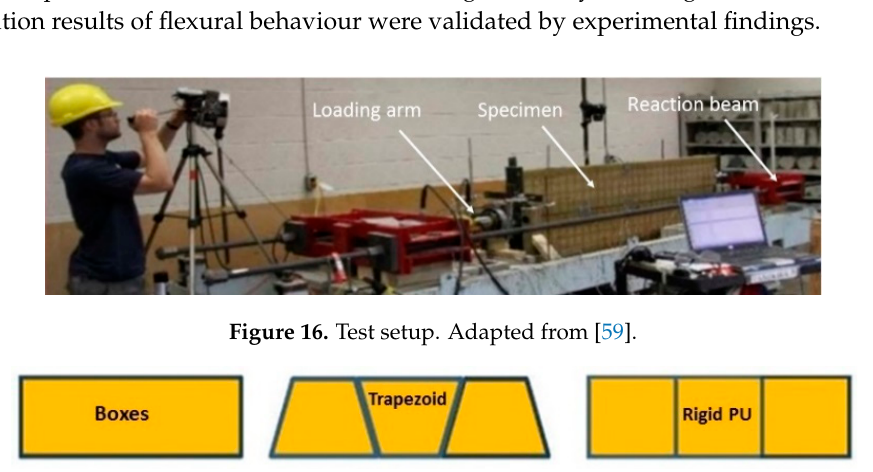
Figure 17. Investigated Composite panels. Adapted from [60]. Figure17. Investigated Composite panels. Adapted from [60]. Figure17. Investigated Composite panels. Adapted from [60].